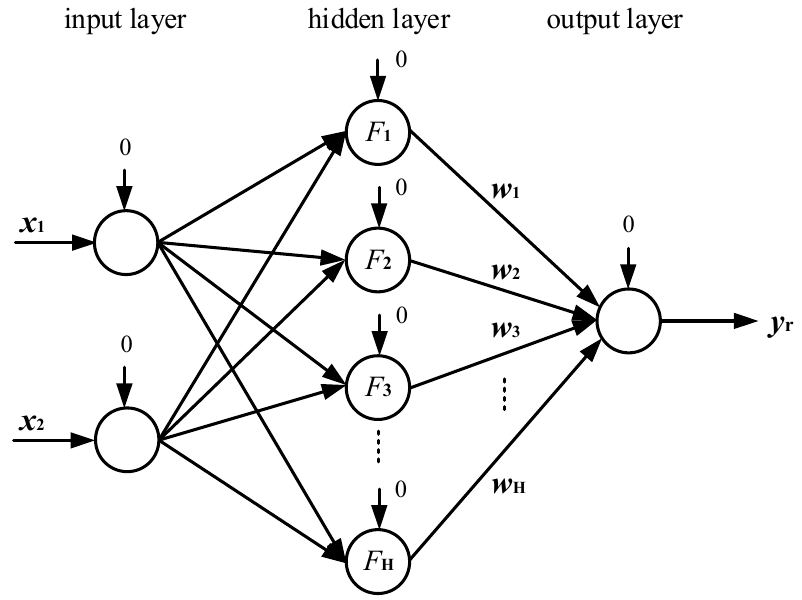
Figure 4. The structure of Chebyshev polynomial of Class 1 neural network. In order to determine the optimal number of hidden neurons which may exert a significant influence on the performance of the neural network, the structure determination algorithm, which is an uncertain accuracy method, is employed [24,25], and the corre- sponding flowchart is given in Figure 5. For the structure determination algorithm, the calculation formula of the half mean square error ( HE ) needs to be given as follows: